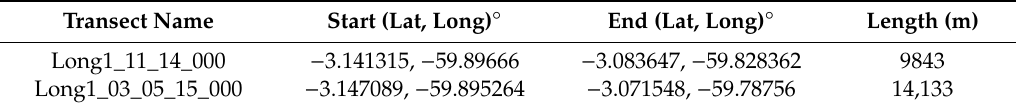
Table 3. Locations and length of the ADCP transects collected in FS − CNS1 and FS − CNS2.